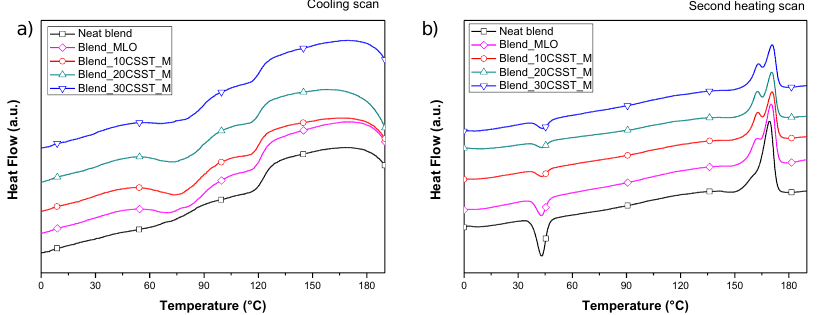
Figure 9. DSC curves for neat PBAT/PBVH and blend_10CSS based composites (Panel A) and for neat PBAT/PBVH, blend_MLO and blend_CSST_M based composites (Panel B) during cooling ( a ) and second heating ( b ) scans.